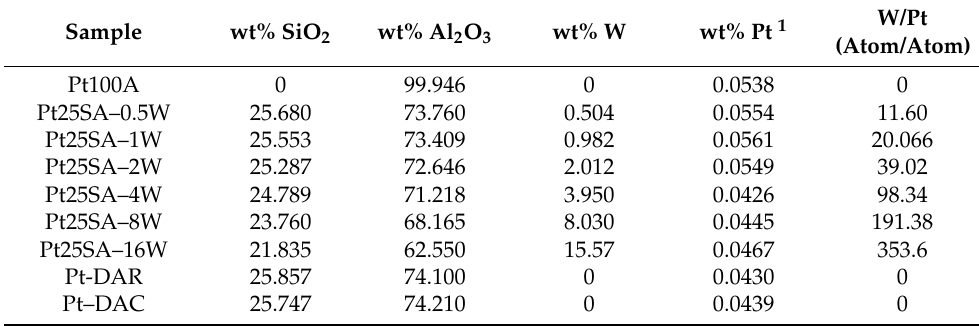
Table 9. Composition (wt%) of the Pt25SA–WO x catalysts calcined at 550 ◦